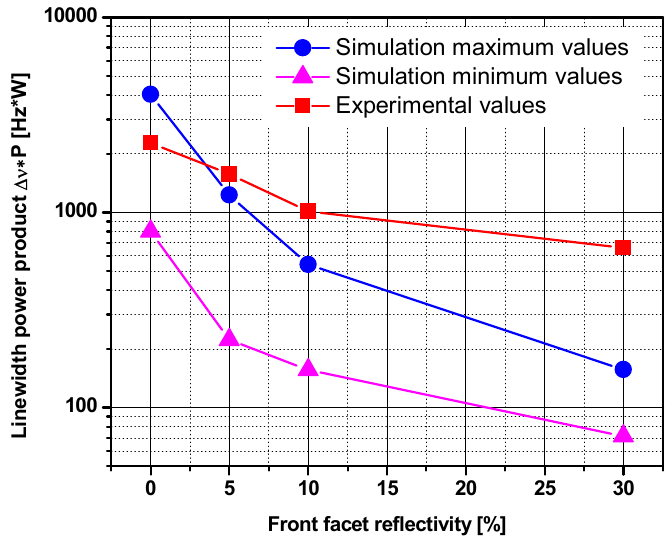
Figure 6. Linewidth power product of 780 nm DFB diode laser vs. front facet reflectivity: Minimum simulation values (pink solid triangle), maximum simulation values (blue solid circle), and experimental values (red solid square).